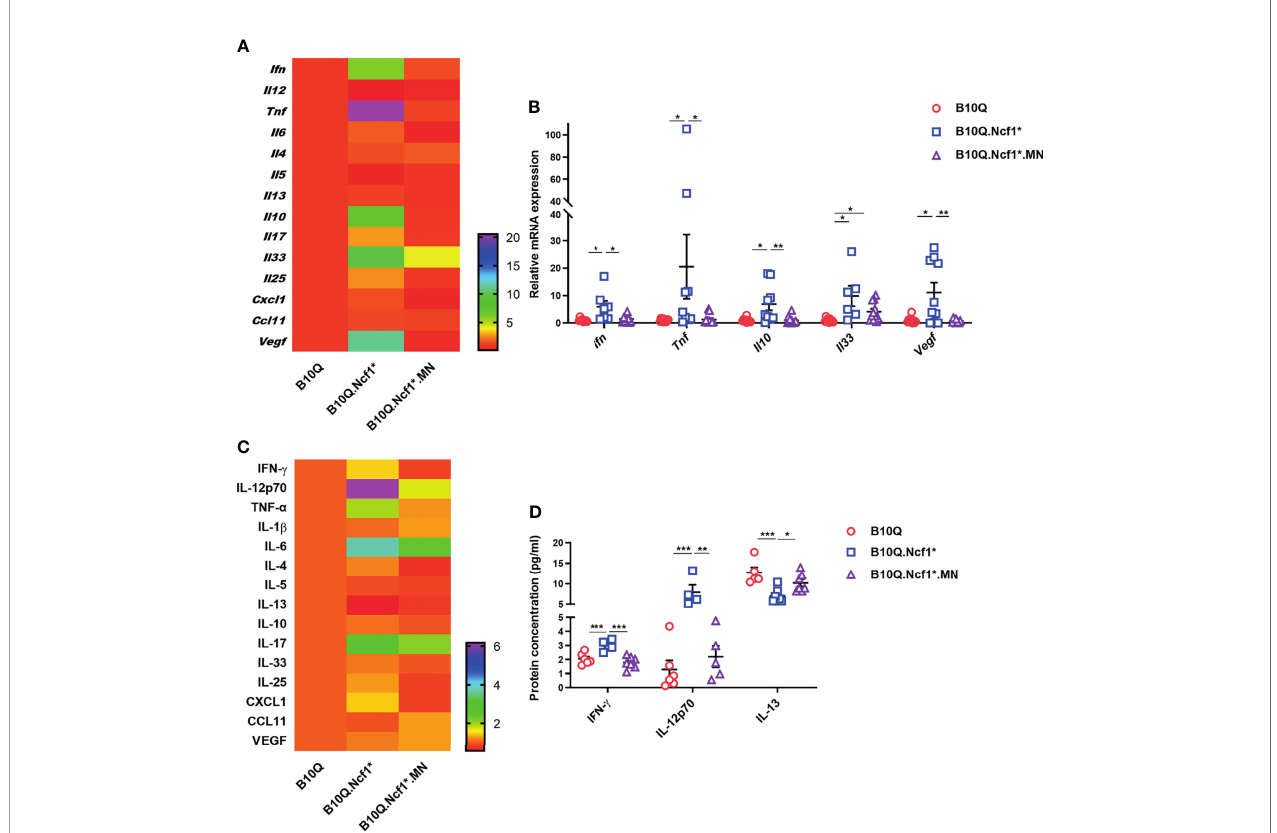
FIGURE 4 | Ncf1 alters type 1 and 2 responses in lungs of AIPI. (A, B) mRNA expression of cytokines and chemokines in lung tissues of AIPI mice were detected by RT-qPCR (n = 6-12 per group). (C, D) The protein concentration of various cytokines and chemokines in serum of three genotypes of mice were detected by Luminex assay (n = 4-7 per group). The heat maps (A, C) showed the mean values of gene/protein expression in each group of mice (B10.Q group is set as one in heat maps), and the statistically different gene/protein expression are shown in the histograms (B, D) . All values are expressed as means ± SEM. * P < 0.05, ** P < 0.01 and *** P < 0.001, using one ‐ way ANOVA with post ‐ hoc comparison (Fisher ’ s)